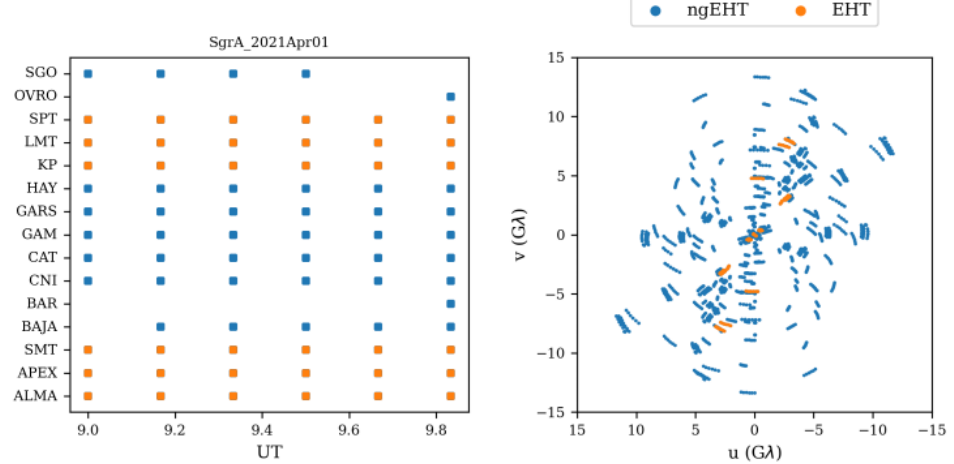
Figure 9. ( Left ) Stations that participate during an hour of observations with the best ( right ) u–v coverage on 1 April 2021, for SgrA*. The orange markers show the observations and u–v points corresponding to the EHT, while the blue markers are the ones that correspond to the added stations and frequency coverage from the hypothetical ngEHT